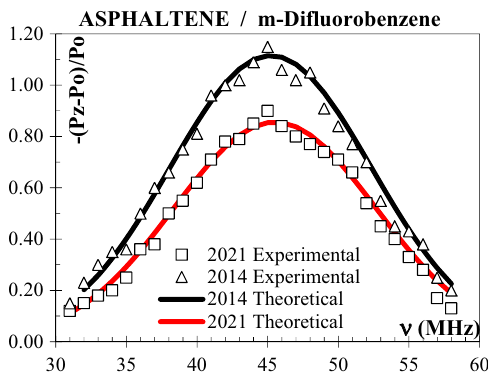
Figure 6: The EPR spectrum acquired in the study ( ▯ ) and Kirimli ’ s EPR spectrum ( 2014 ) ( Δ ) [ 30 ] .